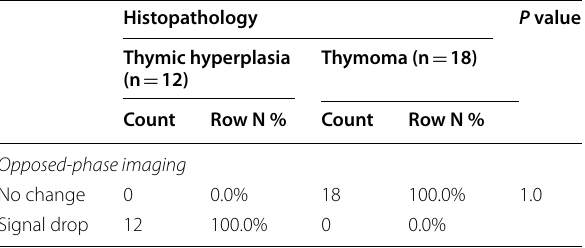
Table 1 Paired comparison between chemical shift MRI and histopathology